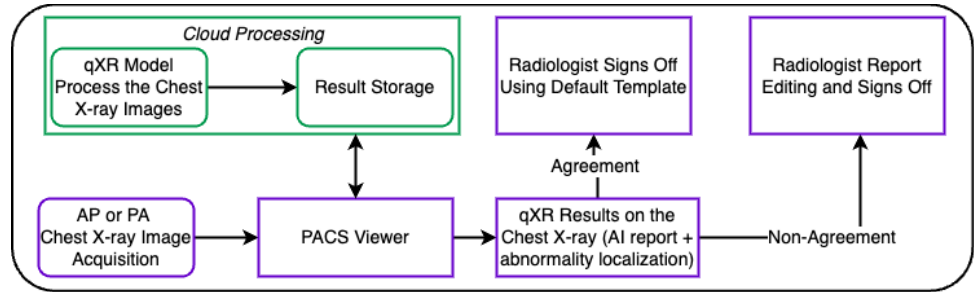
Figure 1. Flow diagram illustrating qXR assisted reporting process followed during this study across different study